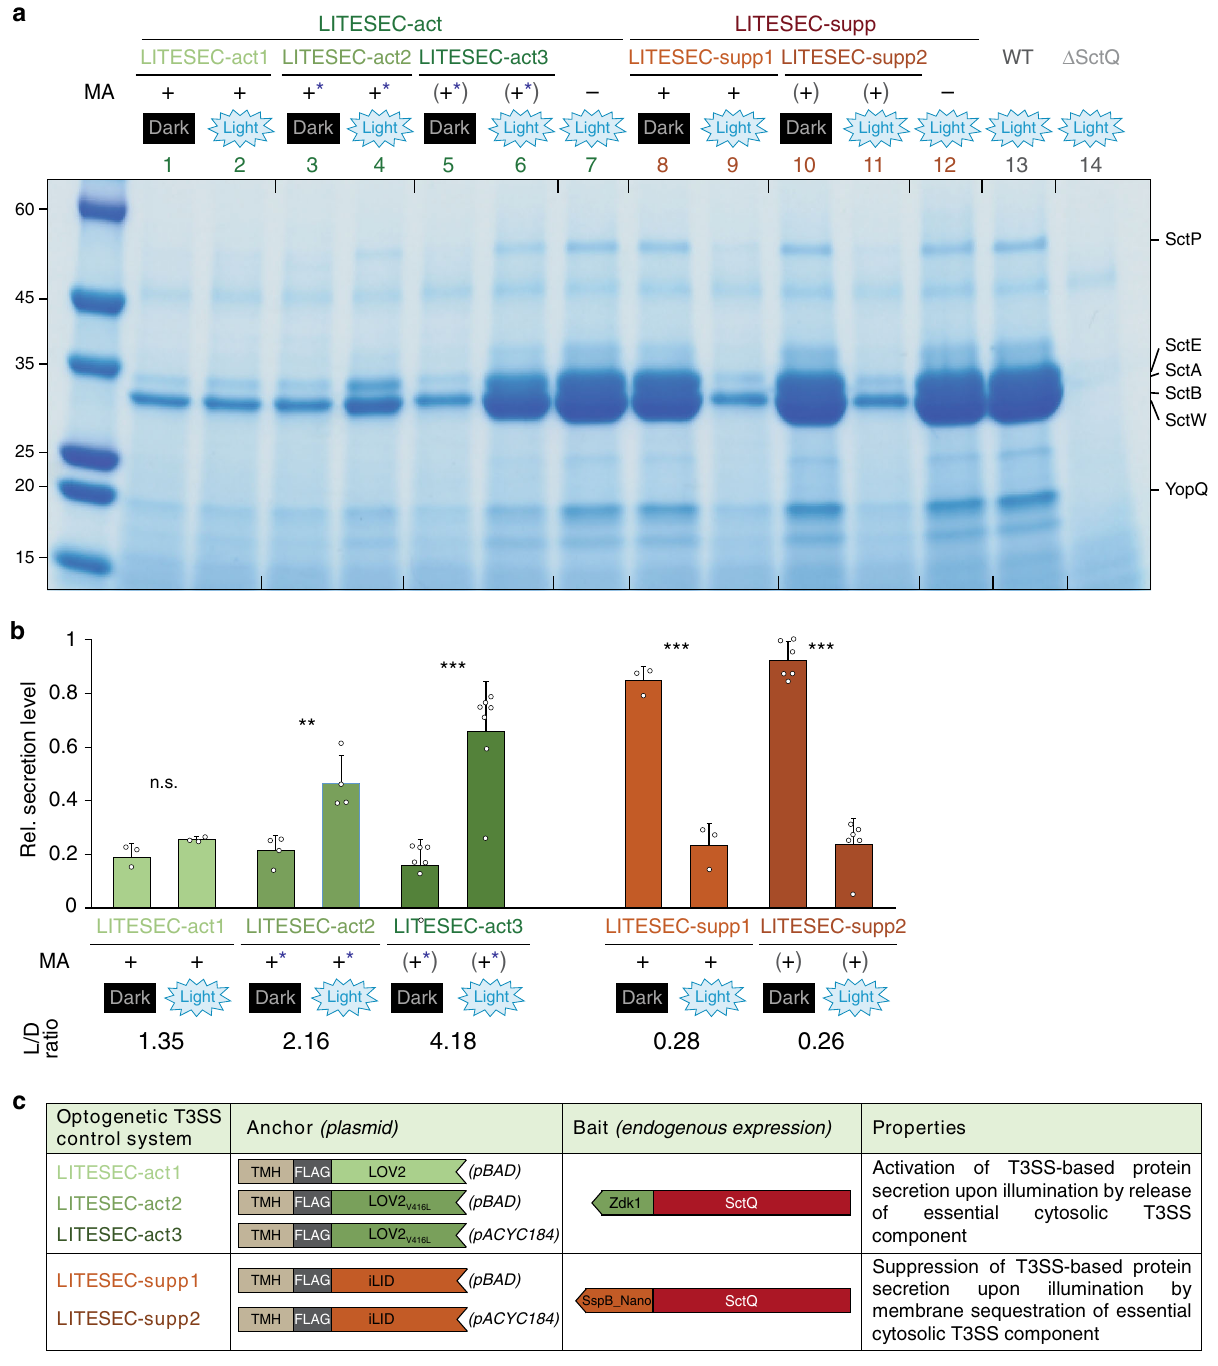
Fig. 4 Secretion ef fi ciency and light responsiveness in different versions of the LITESEC strains. a In vitro secretion assay showing light-dependent export of native T3SS substrates (indicated on the right) in various variants of the LITESEC-act strains (lanes 1 − 7) and LITESEC-supp strains (lanes 8 − 12), as indicated below. Proteins secreted by 3 × 10 8 bacteria during a 180-min incubation period were precipitated and analyzed by SDS-PAGE. Left side, molecular weight in kDa. MA expression level of membrane anchor, + high expression level, ( + ) low-expression level; − no expression. *, V416L anchor mutant. b Quanti fi cation of secretion ef fi ciency and light/dark secretion ratio (L/D ratio) for the different LITESEC strains and illuminations indicated above (as in ( a )). Secretion ef fi ciency was determined by gel densitometry for the SctE/SctA/SctB/SctW bands and normalized for the secretion ef fi ciency in wild-type strains (lane 13 in ( a )). N = 3/6/3/4/7 gel densitometry values from independent experiments for both conditions for LITESEC-act1/2/3/- supp1/2, respectively. Bars show mean values; error bars display standard deviation. Single data points indicated by circles. ** p < 0.01; *** p < 0.001 in a two-tailed homoscedastic t test; n.s. difference not statistically signi fi cant (exact values from left to right, 0.08/0.005/4 × 10 − 5 /4 × 10 − 4 /5 × 10 − 8 ). Source data are provided as a Source Data File. c Schematic overview of the LITESEC systems and their optogenetic components. All bait proteins are expressed from their native genetic locus. TMH, extended transmembrane helix (see “ Methods ” for